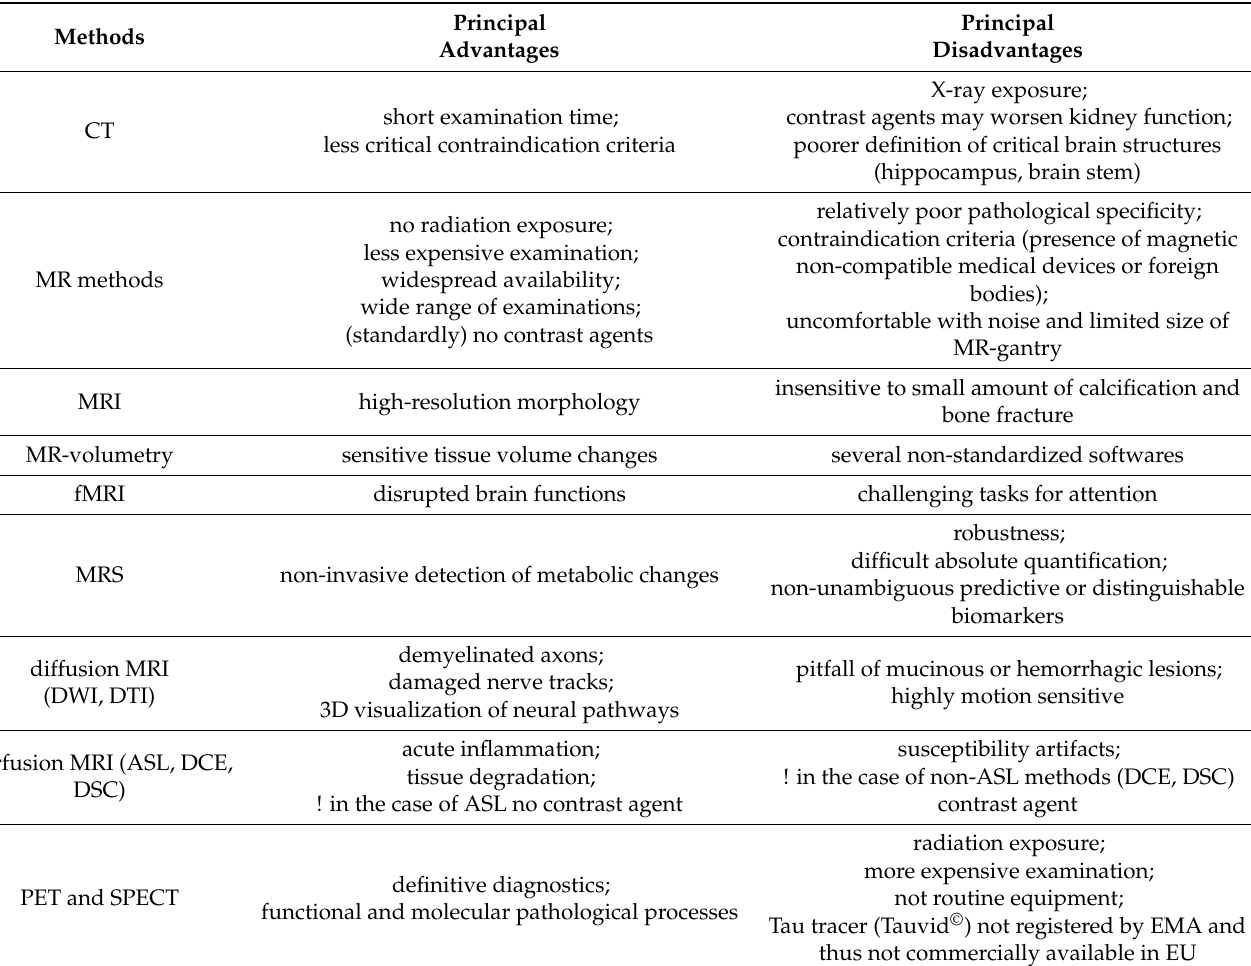
Table 1. An overview of the most distinctive advantages and disadvantages of neuroimaging methods applicable for AD assessment. Abbreviations: ASL, arterial spin labeling; CT, computed tomography; DCE, dynamic contrast-enhanced magnetic resonance imaging (MRI); DSC, dynamic susceptibility contrast-enhanced MRI; DTI, diffusion tensor imaging; DWI, diffusion weighted imaging; EMA, European Medicines Agency; EU, European Union; fMRI, functional MRI; MRS, mag- netic resonance spectroscopy; PET, positron emission tomography; SPECT, single-photon emission computed